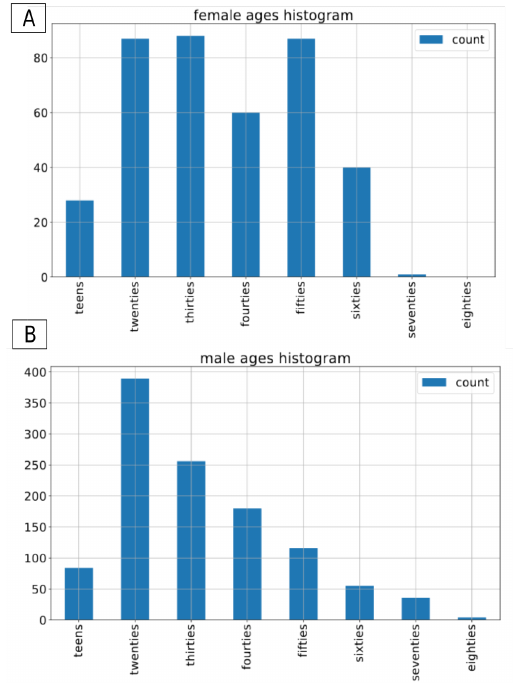
Figure 2. Common Voice: age distribution by gender in the validation dataset. ( A ) for female speakers, ( B ) for male